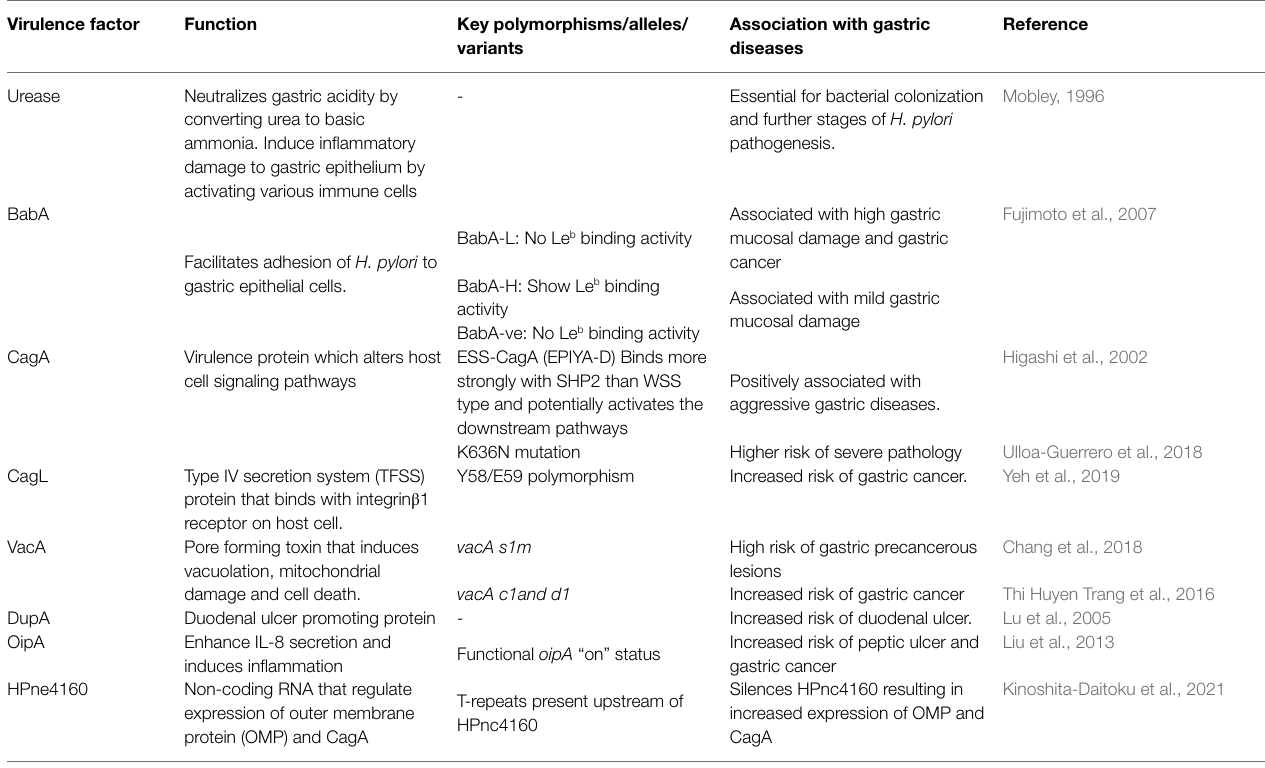
TABLE 2 | Virulence factors of H. pylori and their polymorphisms associated with gastric